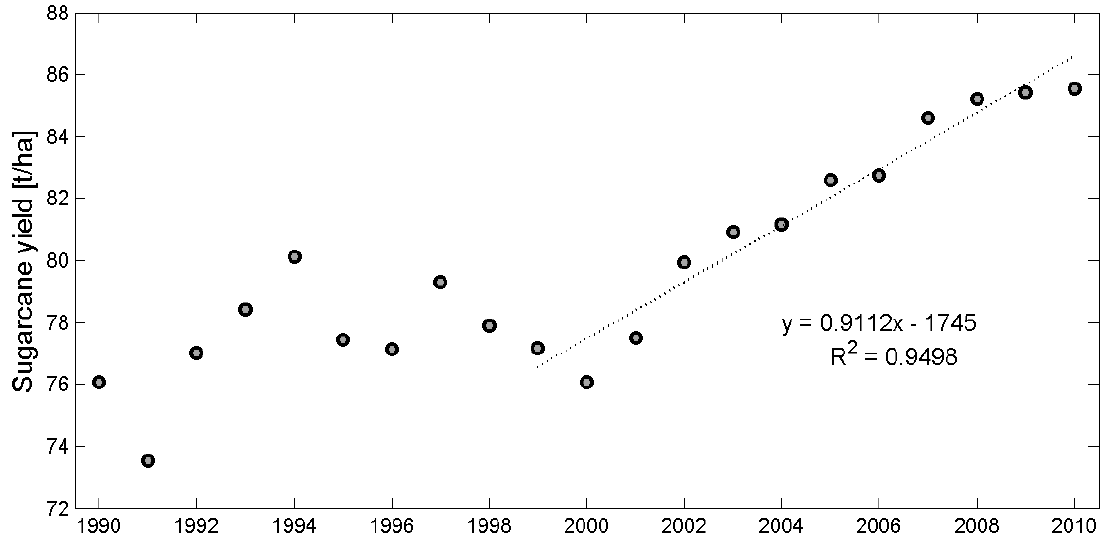
Figure 6. Evolution of São Paulo state sugarcane yield in the period 1990–2010. Dashed line represents the trend for study period